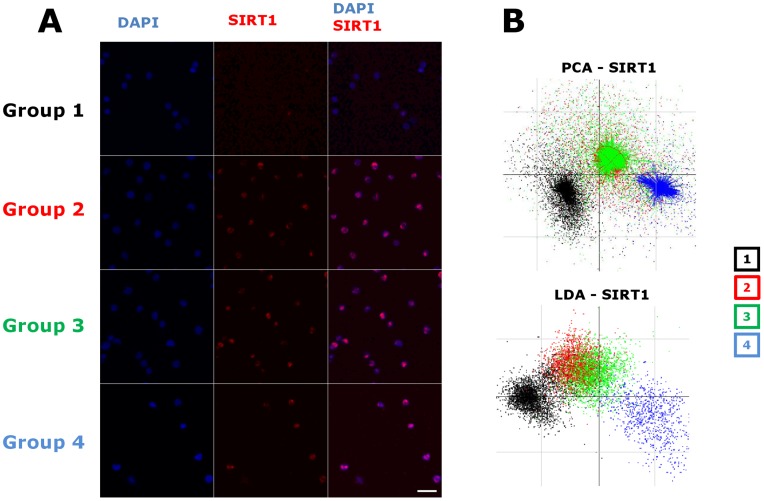
High-content image analysis of the heterogeneous population of SIRT1 immunostained cells of the four groups suggests changes in the cell nucleus.
A. Examples of images used for the analysis of SIRT1 expression representative of 9 experiments. The groups and colour codes are the same as indicated on the Figure 1. Scale = 50 micrometers. Confocal analysis was performed on a LEICA TCS SP2 microscope (Leica Microsystems) with the Leica Confocal Software. Images were acquired with a 40X HCX PL APO Plan Fluor oil objective (NA 1.25) at room temperature. For display, the images were processed using ImageJ a median filter 3 pixels followed by an image adjustment, increasing the brightness was performed equally on all the Red images. The nuclei were stained with DAPI and the SIRT1 antibody was labelled with Alexa 594 B. Upper plot: A representative example of the principal component analysis of the data extracted from the SIRT1 immunostaining images. Individual cells are visualized as points on the scatter plot of the first two principal components describing the variation. They were identified by the colour code according to their group of origin only after their position on the scatter plot is calculated. Note that cells from the same experimental group tend to cluster. The groups 2 and 3 overlap. Lower plot: Representative example of the LDA analysis of the same data. This alternative multiparametric analysis takes into account the existence of four groups and helps to visualize the differences between them. Note the overall similarity of the LDA and PCA scatter plots.